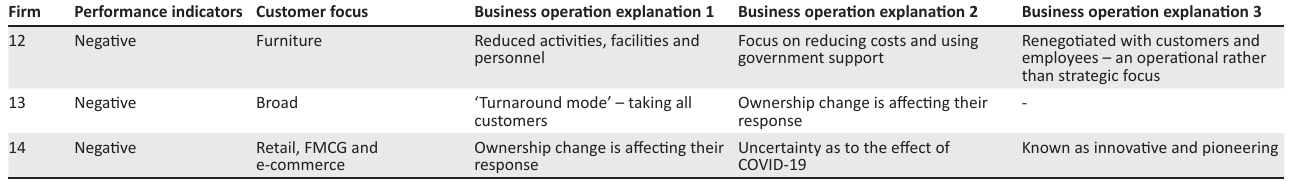
TABLE 5: Per company findings: Struggling. Firm Performance indicators Customer